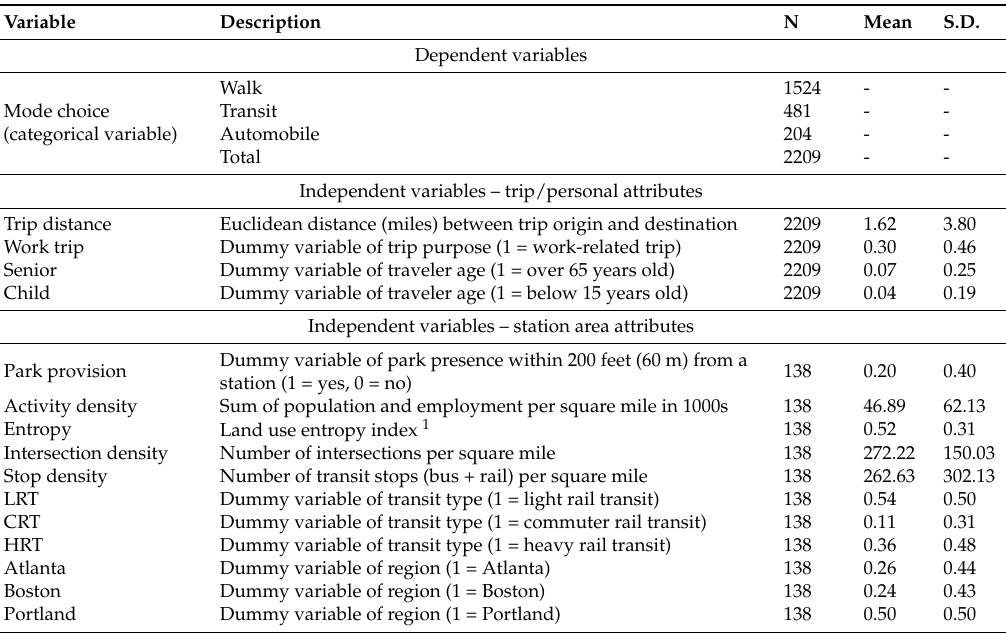
Table 2. Descriptive